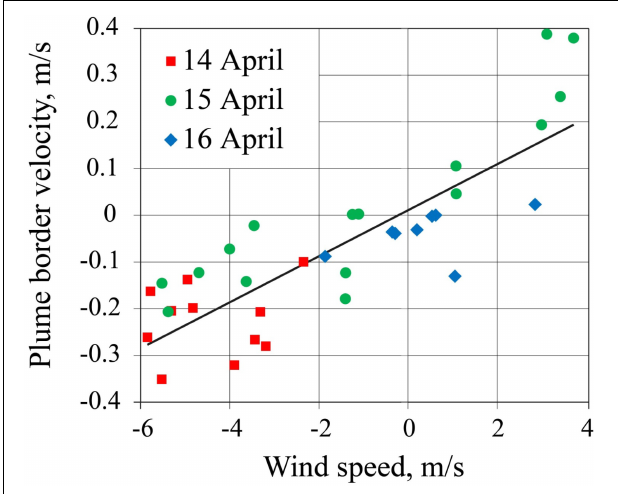
FIGURE 4 | Dependence between zonal wind speed and movement velocity of the plume outer border during the field survey. The black line indicates the linear